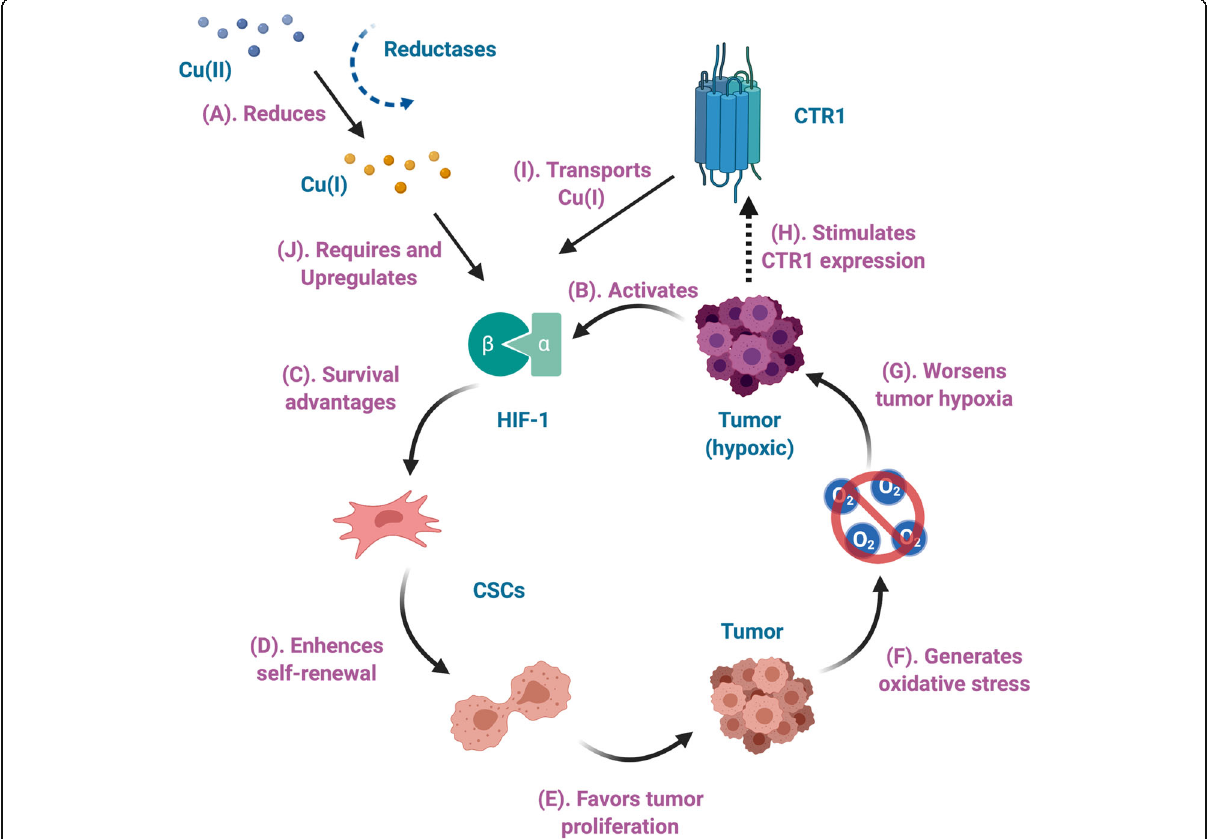
Fig. 2 Possible role of copper in tumor hypoxia. a Cu(II) is reduced to Cu(I) by metalloreductases. b Hypoxic tumor activates the hypoxia- inducible factor 1 (HIF-1). c Activation of HIF-1 promotes cancer stem cells (CSCs) via survival advantages, which d enhances the self-renewal ability and inhibitsdifferentiation of CSCs. e In effect this is in favor of tumor proliferation, which f generates oxidative stress, and g further worsen tumor hypoxia. On the other hand, h tumor hypoxia stimulates copper transporter 1 (CTR-1) expression, increases the production of CTR-1 to i transport incoming Cu(I), j upregulating the HIF-1 expression, where Cu(I) is